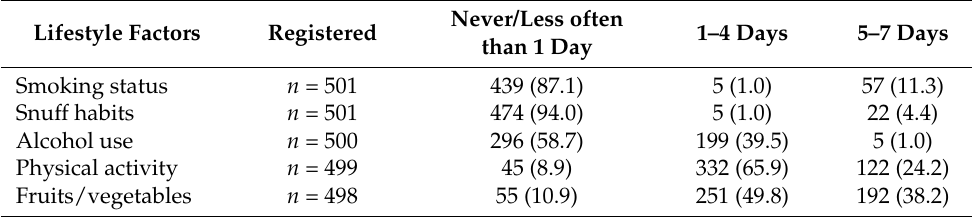
Table 3. Lifestyle factors in frequency ( n ) and percentage (%) for the